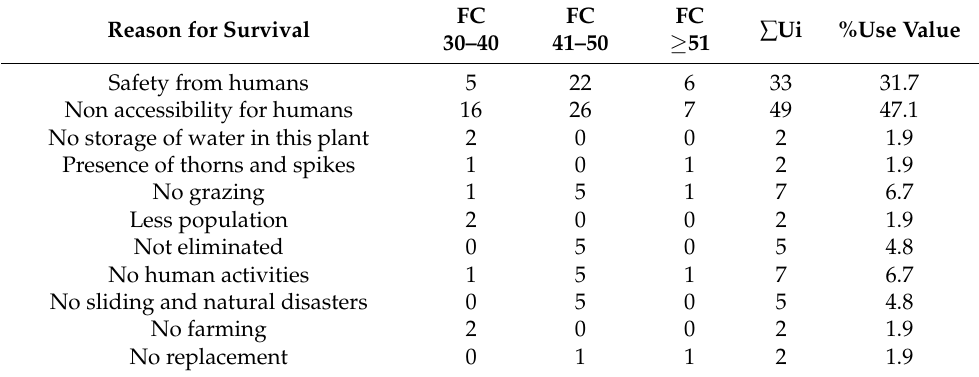
Table 2. Reasons for survival of Berberis lyceum Royle in District Shangla, Khyber Pakhtunkhwa,